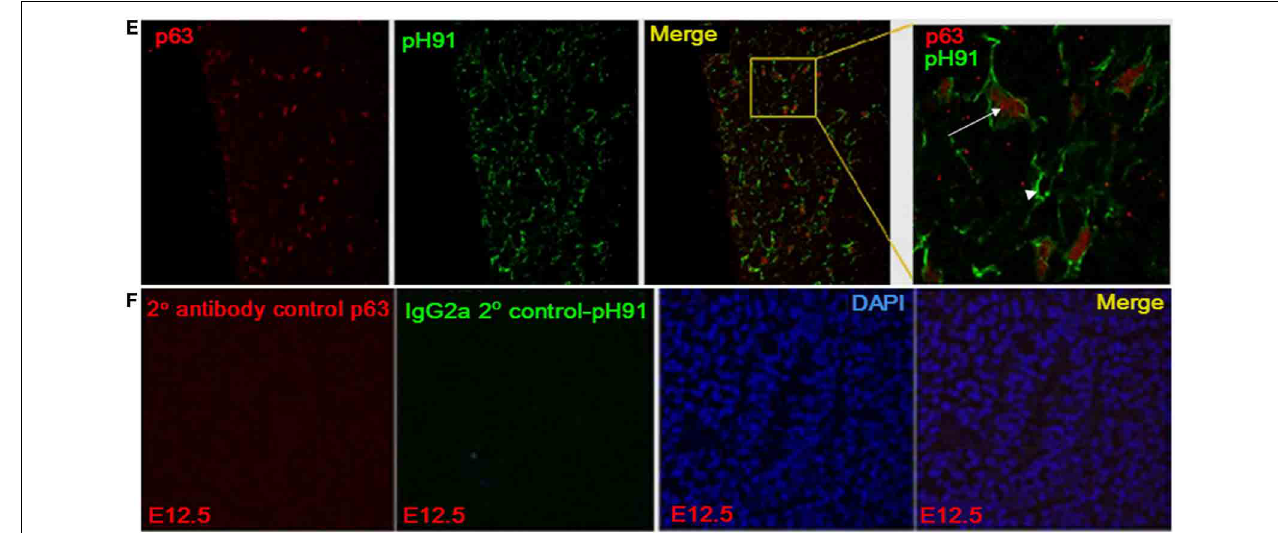
FIGURE 4 | Expression of p63 by pH91 + TECs. (A) shows thymic anlagen at E12.5 stage of development (sagittal section). Sections were stained with antibodies against p63 (red), pH91 (green), and DAPI (blue). Merged images at each developmental stage are shown in the right subpanels. Expression of p63 is seen in the nucleus of pH91 + epithelial cells. (B–E) show stained thymic sections with anti-p63 (red) and pH91